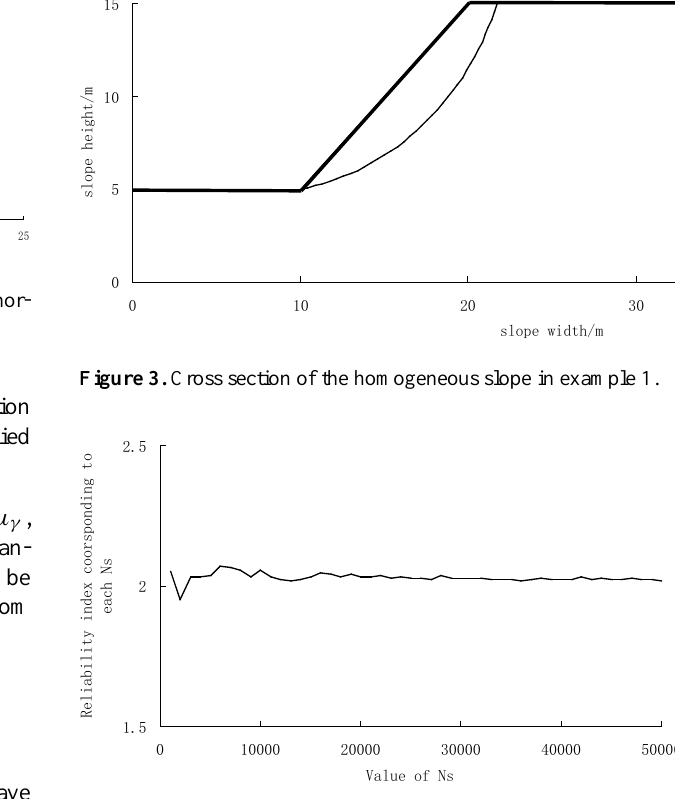
Figure 4. Numerical convergence of reliability index with different values of